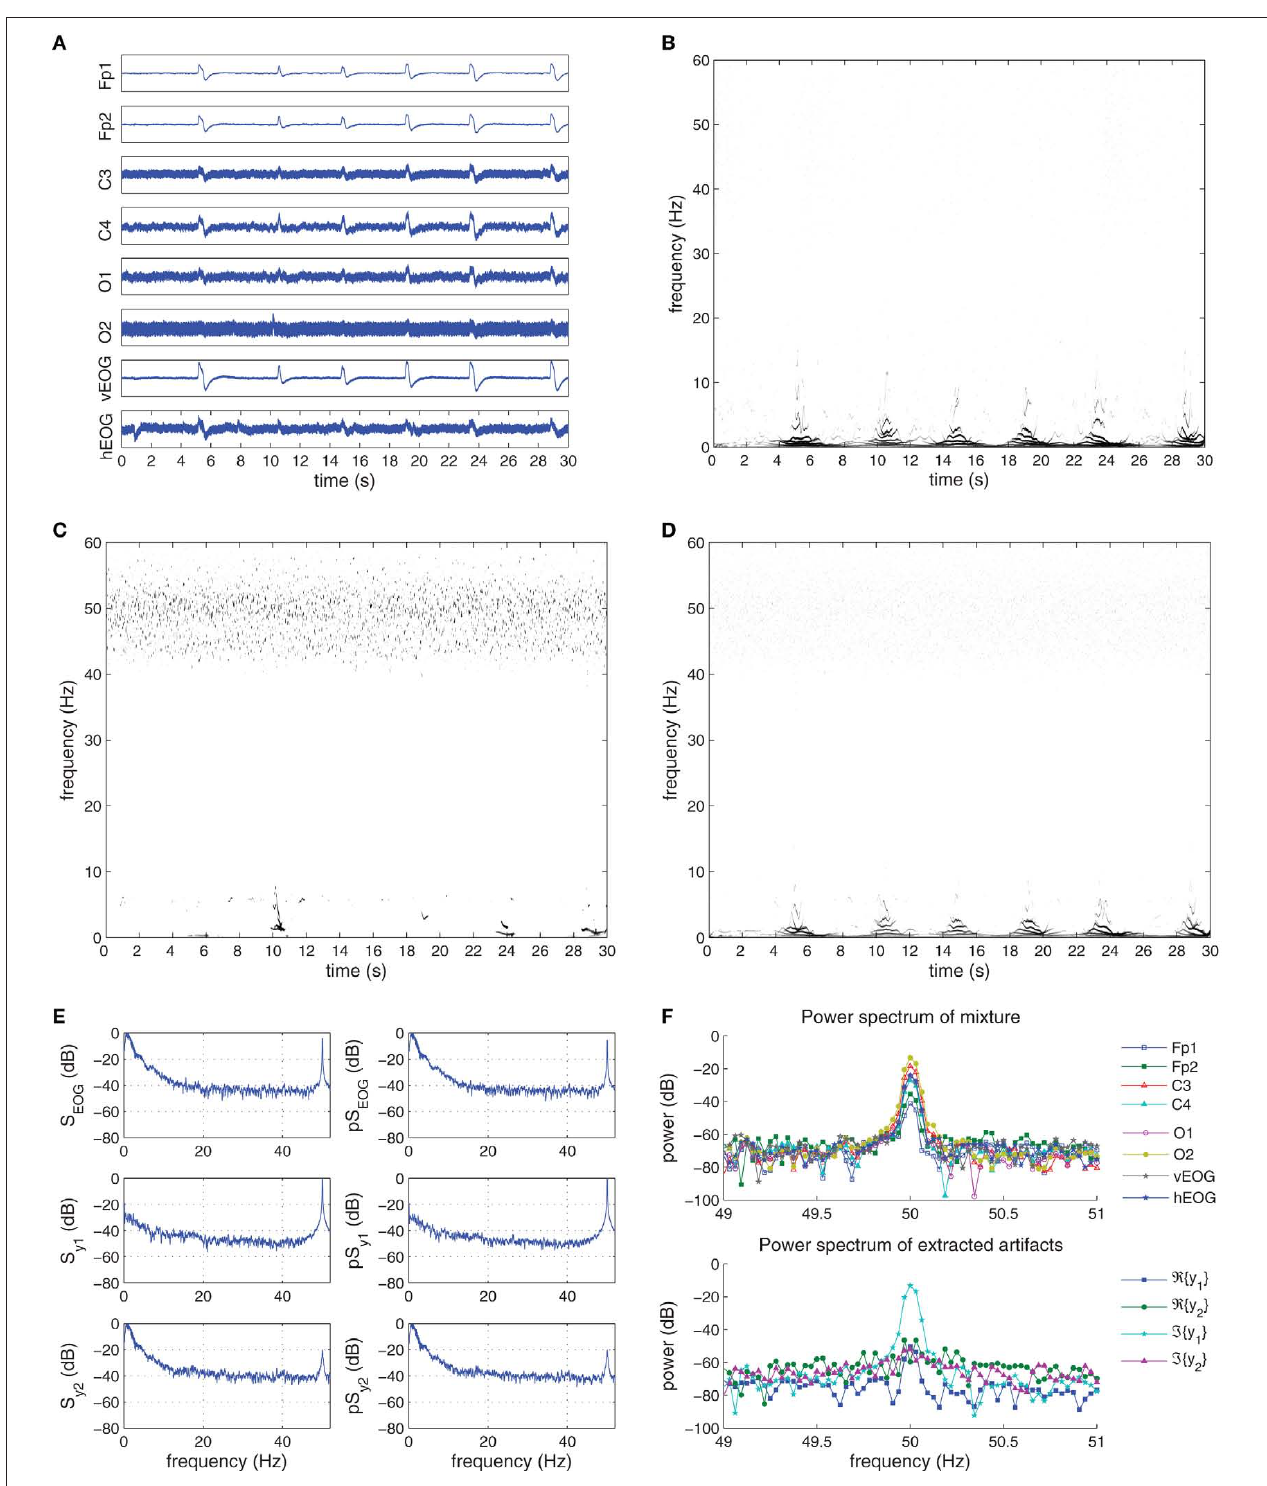
and pseudo-spectra (pS) of the recorded EOG, and the extracted signals y and y ( k ). (F) The power spectra (S) and pseudo-spectra (pS) of the recorded EEG signals and the extracted artifacts at the 50-Hz frequency range. After extraction, the power line noise is contained in I { y